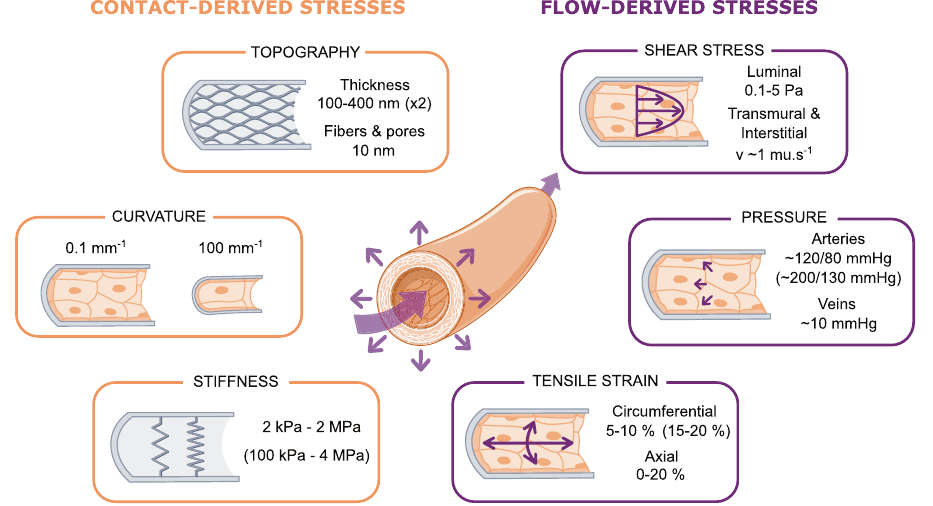
Fig. 1 Summary of the biophysical forces present within the vasculature. Endothelial cells (ECs) within blood vessels are subjected to various mechanical cues, from the substrate (orange, left panels) or from the blood fl ow (purple, right panels). Physiological (or pathological in parentheses) ranges of values are provided for each type of